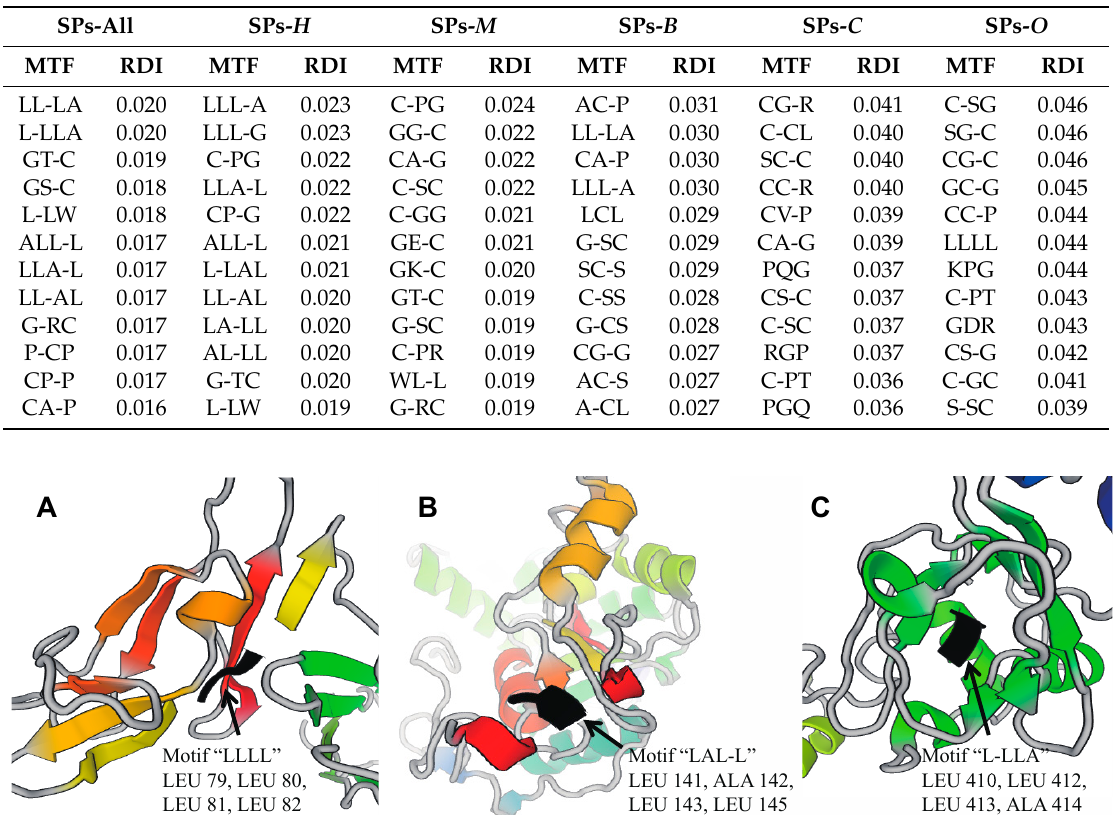
Table 2. The prediction performance of different features on six training datasets over five-fold cross-validation.